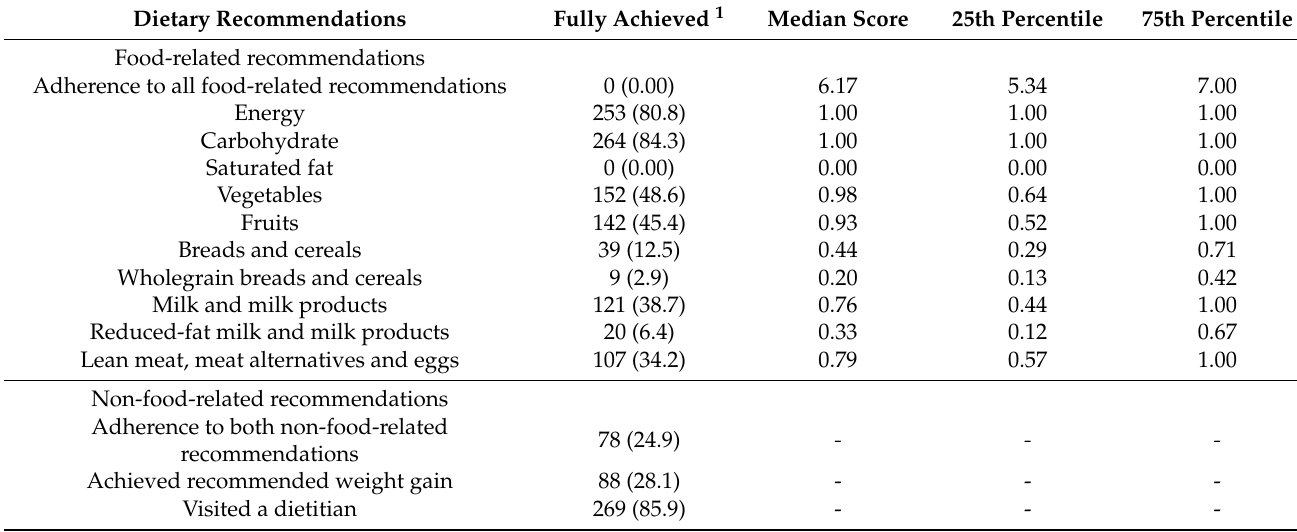
Table 3. Proportion of the 313 women with GDM who adhered to the guideline dietary recommendations and dietary adherence